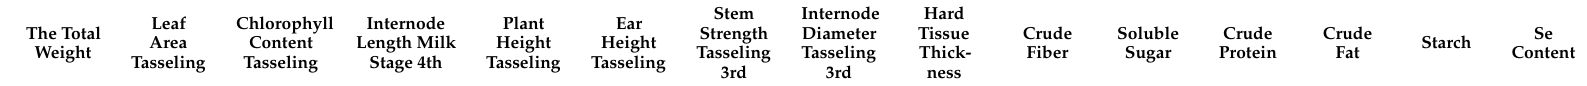
Table 5. Pearson correlation analysis of Se fertilizer and agronomic traits, yield, and quality of dryland maize at location